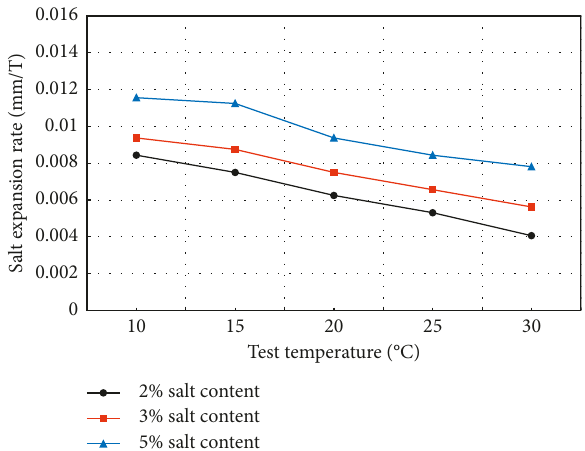
Figure 8: Salt expansion rate of sodium sulfate saline soil affected by temperature and